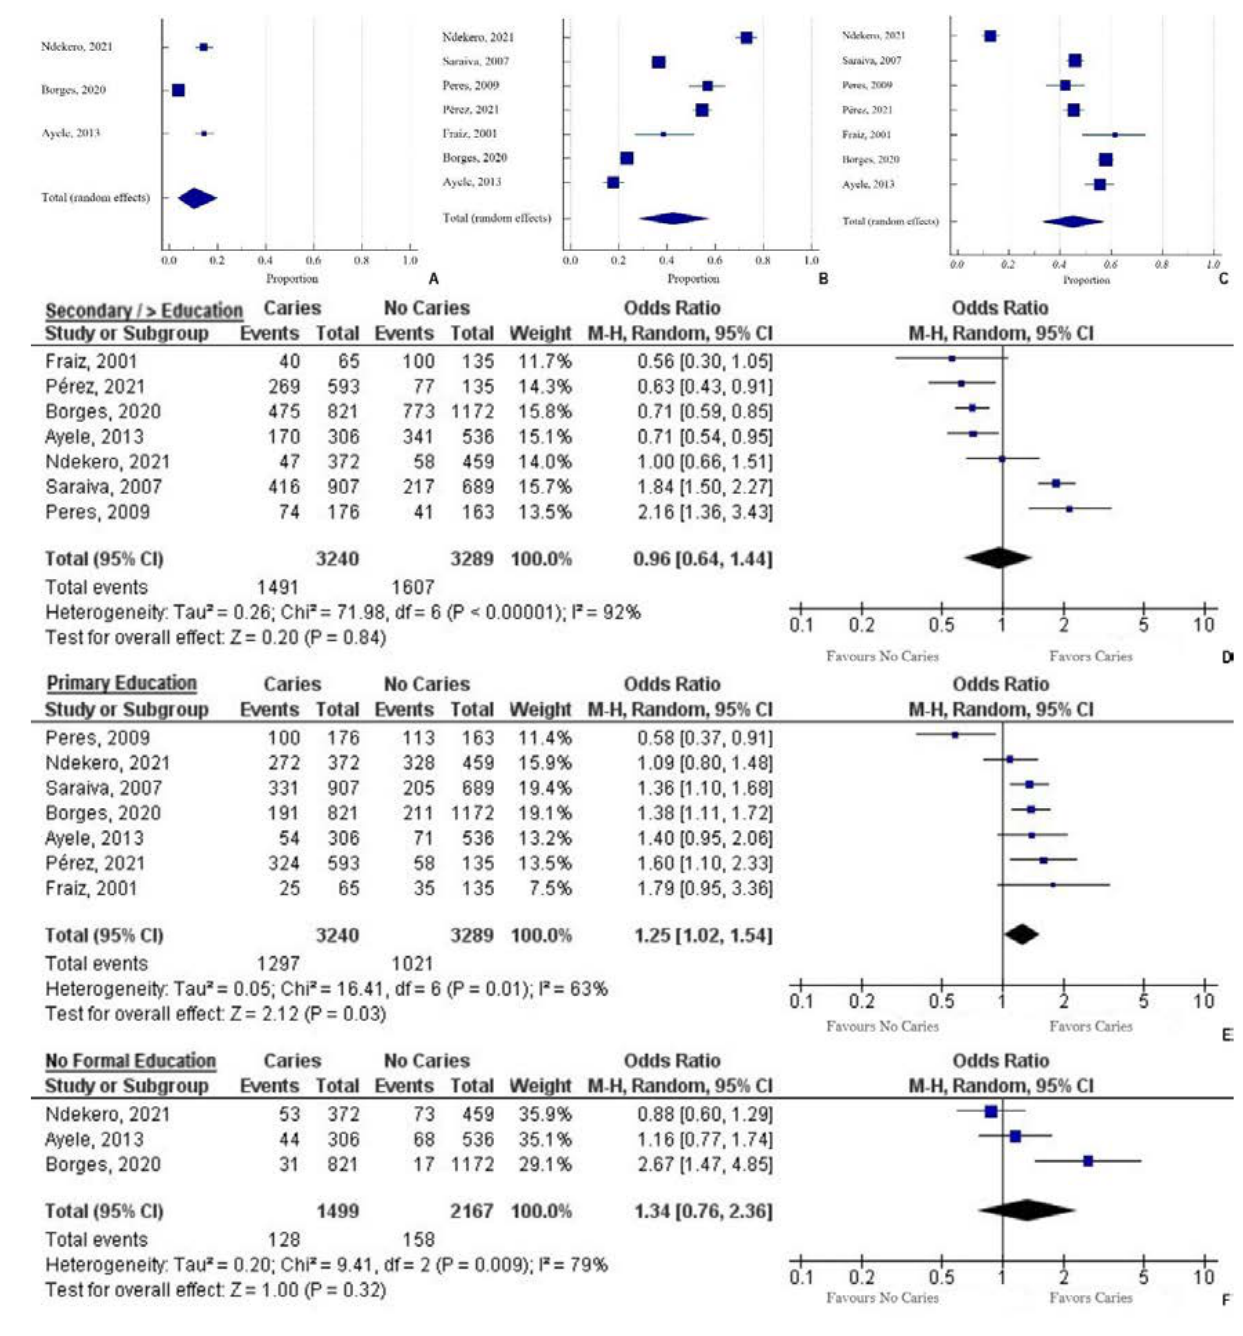
Figure 3. ( A ) Pooled prevalence of no formal education for mothers (n = 128/1499); ( B ) primary edu- cation for mothers (n = 1297/3240); ( C ) secondary and higher education for mothers (n = 1491/3240) of children with caries, presented as a proportion in a forest plot, applying the random-effects model. ( D ) Secondary/higher education: a forest plot depicting the odds ratio (OR) of children having caries compared to no caries. Heterogeneity: Tau 2 = 0.26; Chi 2 = 71.98, DF = 6; I 2 = 92%. Test for overall effect: Z = 0.2 ( p = 0.84); ( E ) Primary education: a forest plot depicting the odds ratio (OR) of children having caries compared to no caries. Heterogeneity: Tau 2 = 0.05; Chi 2 = 16.41, DF = 6; I 2 = 63%. Test for overall effect: Z = 2.12 ( p = 0.03); ( F ) No formal education: a forest plot depicting the odds ratio (OR) of children having caries compared to no caries. Heterogeneity: Tau 2 = 0.2; Chi 2 = 9.41, DF = 2; I 2 = 79%. Test for overall effect: Z = 1 ( p =